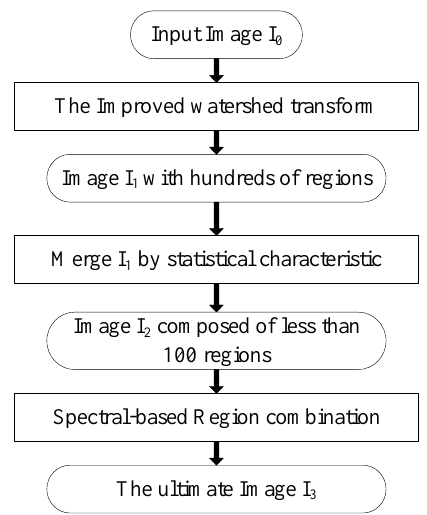
Fig 1. The flow chart of our proposed